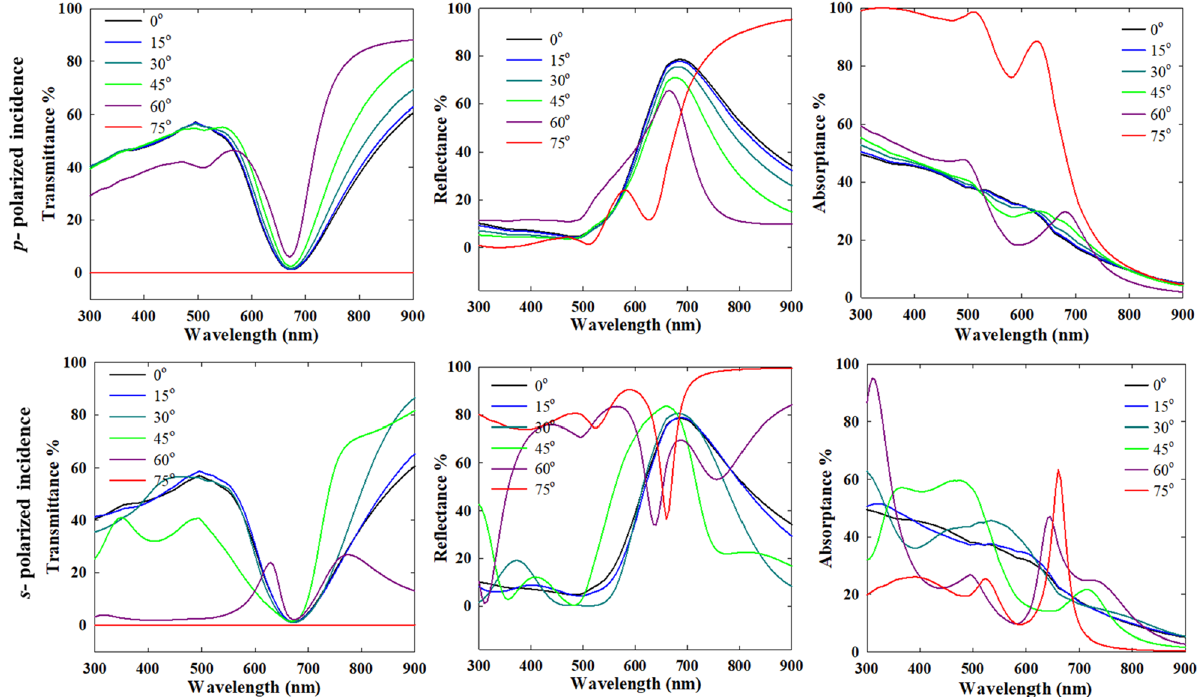
Figure 15. Transmittance, reflectance and absorptance spectra of a close packed 20 nm Au nanoparticle film in the Kretschmann i.e. ATR configuration for p -polarized and s -polarized incident wave, and varying incident angle ( n = 1.5 for the denser medium, n = 1.33 for the lighter